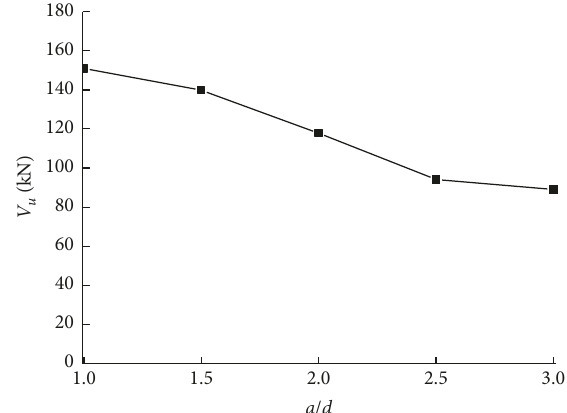
Figure 7: Relationship of shear strength and a / d .